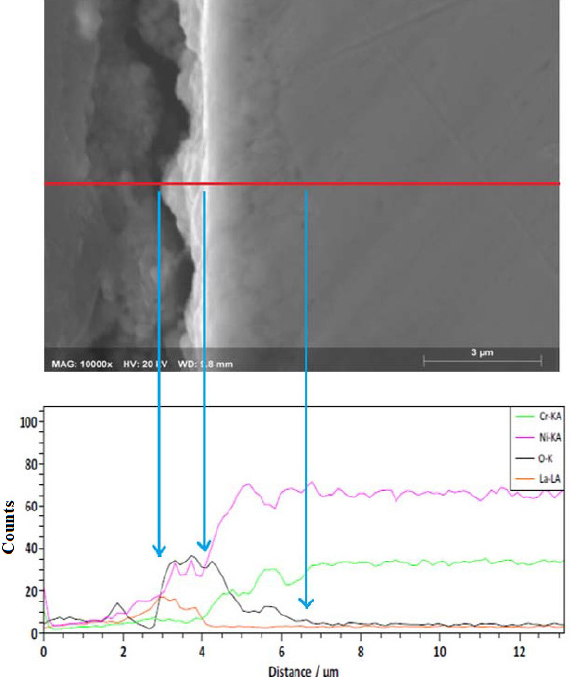
Figure 9. EDS line-scan of Ni20Cr alloy immersed in ternary salt 500 °C for 1000 h.